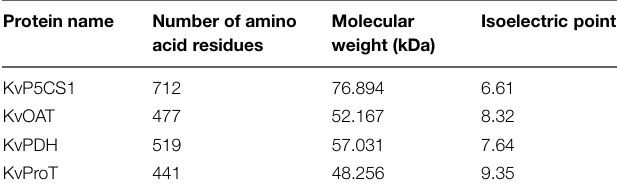
TABLE 2 | The basic features of protein sequences encoded by isolated